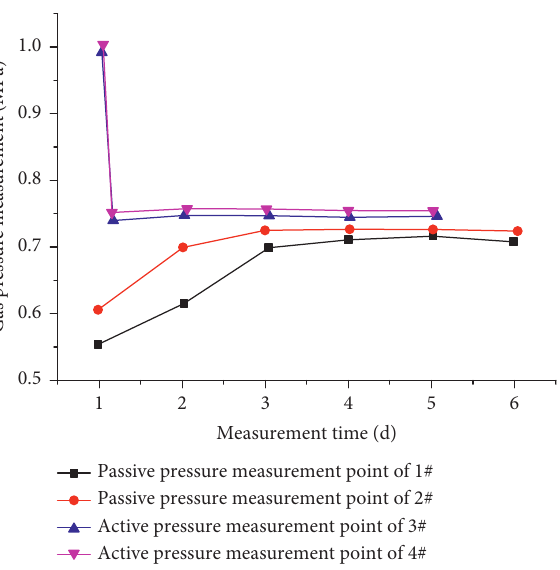
Figure 9: Recovery curve for CBM pressure.